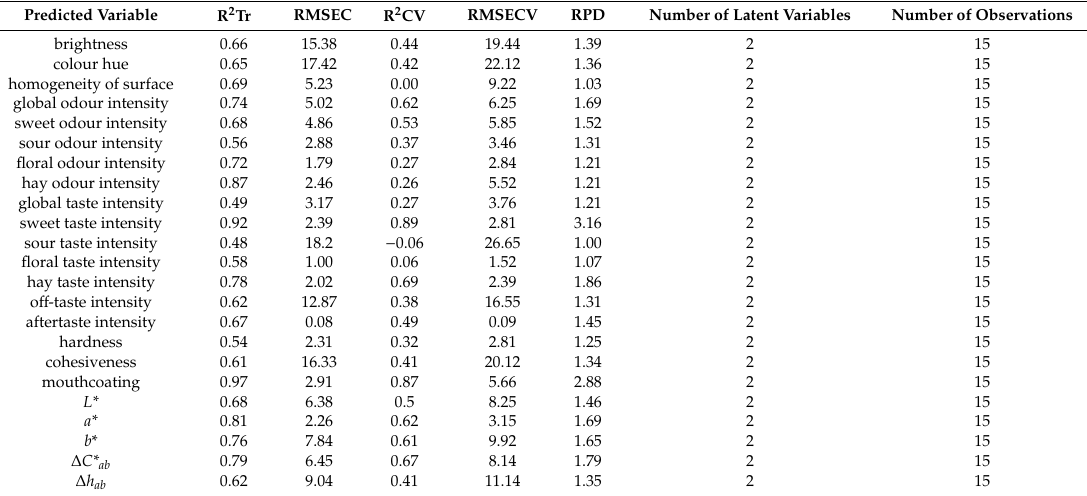
Table 7. Results of the regression models built on the properties of sensory profile analyses and colour parameters of pollen samples based on data of the electronic